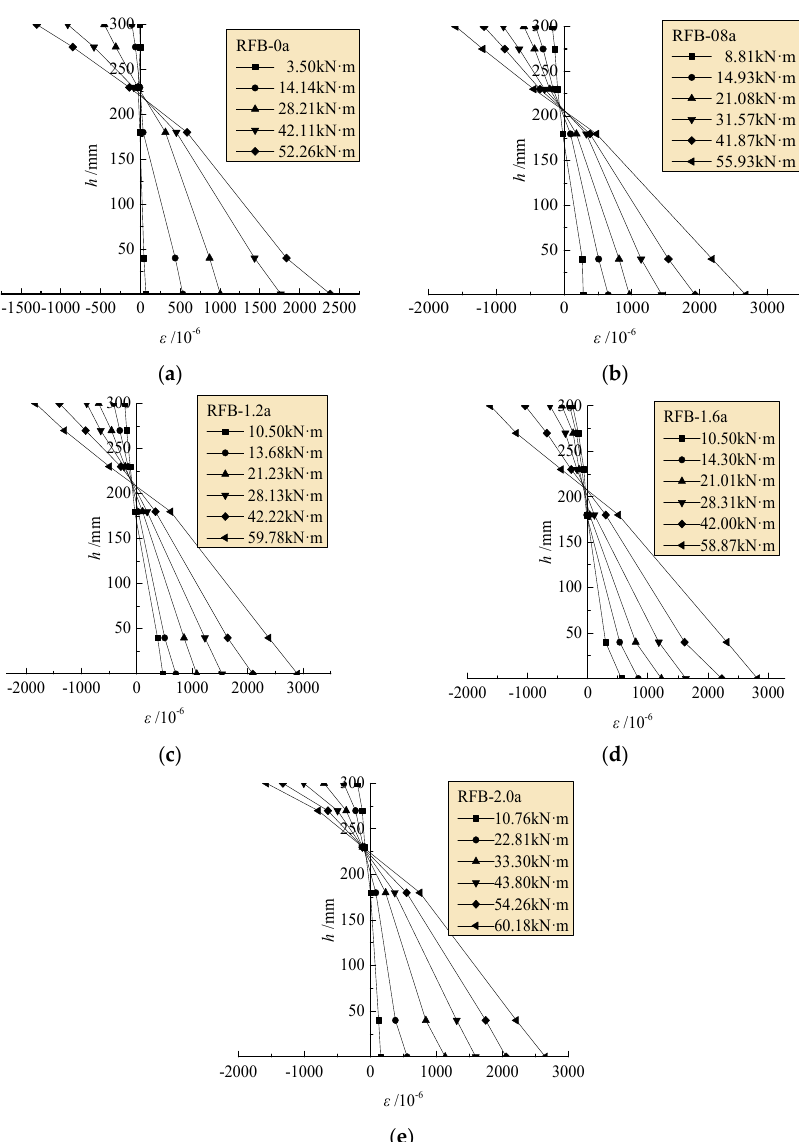
Figure 3. Concrete strain along depth of the mid-span section: ( a ) RFB-0a; ( b ) RFB-0.8a; ( c ) RFB-1.2a; ( d ) RFB-1.6a; ( e ) RFB-2.0a.